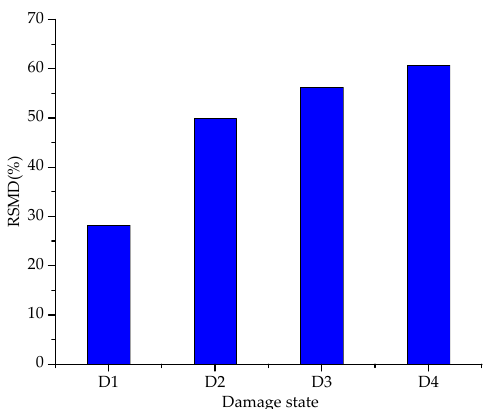
Figure 9. The value of root-mean-square-deviation (RMSD) for different debonding damage at the frequency range of 200–260 kHz at PZT-1.